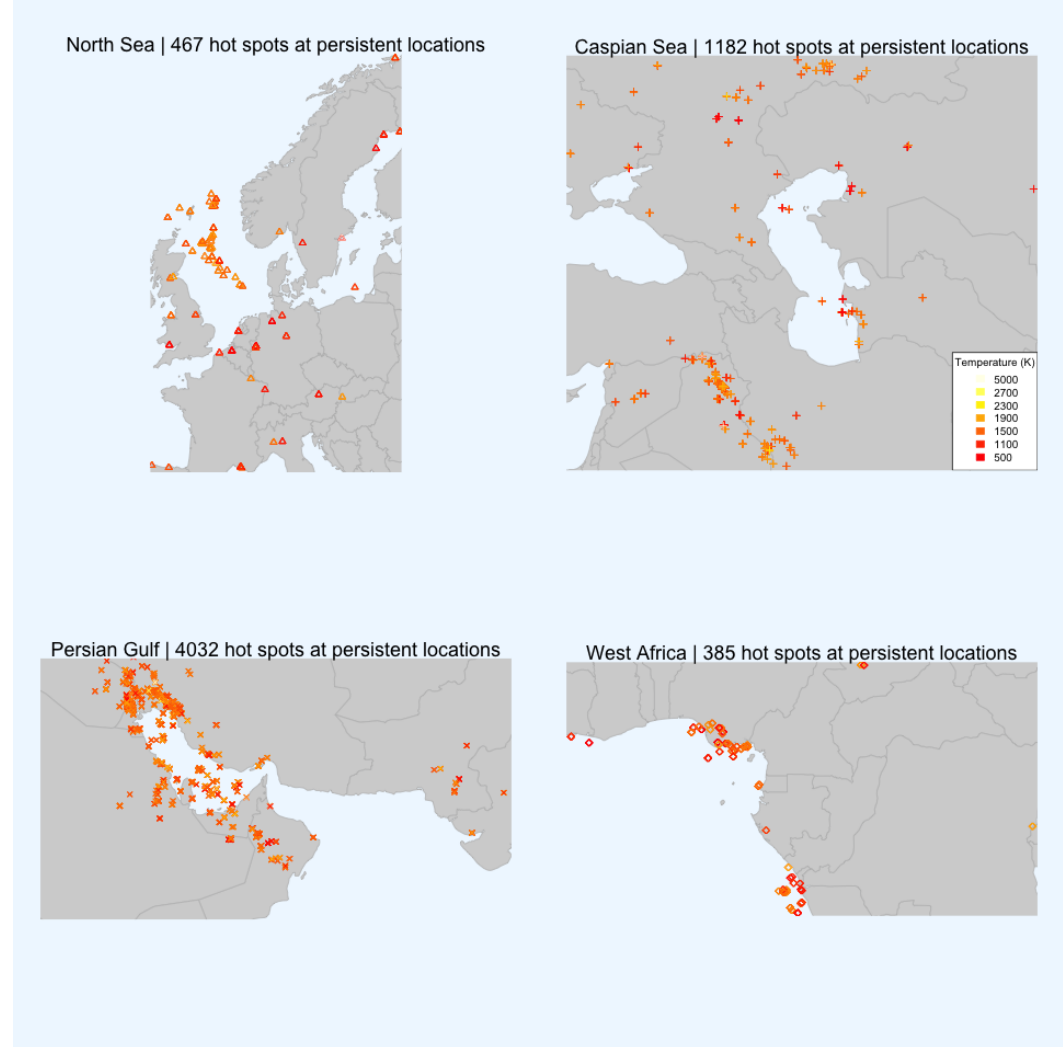
Figure 12. Maps of the persistent hot